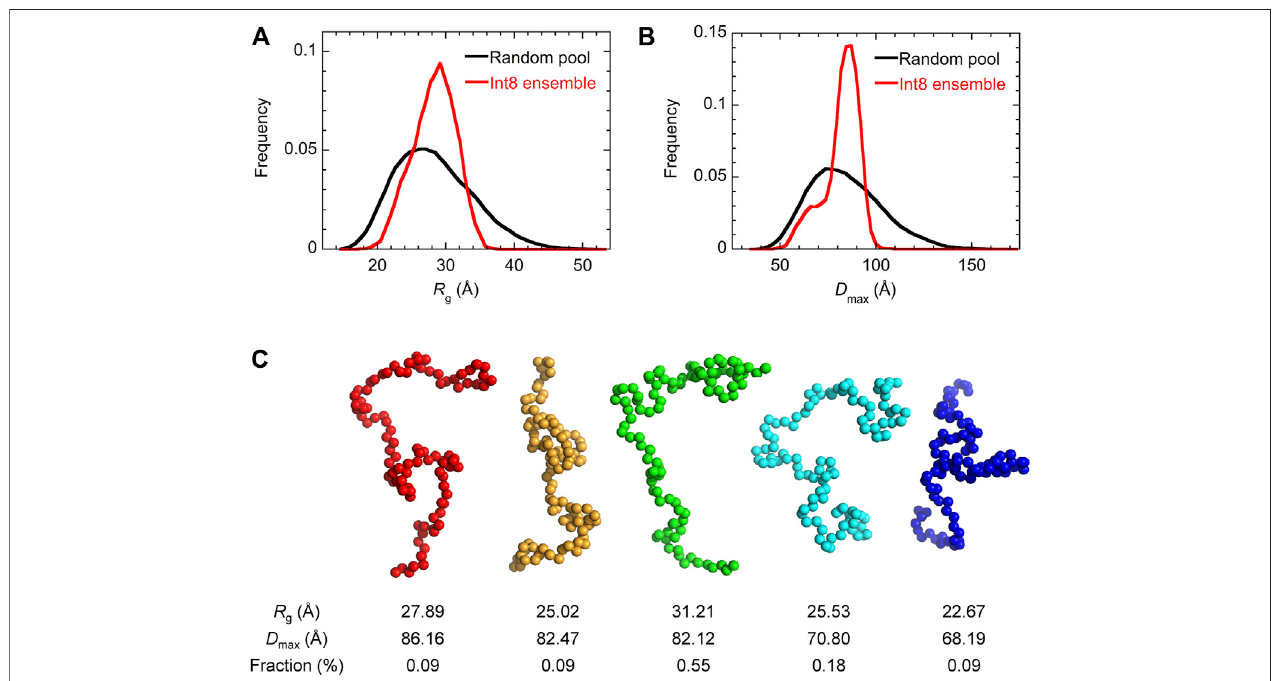
FIGURE 5 | EOM analysis of the SAXS data. (A,B) The distribution of R g (A) and D max (B) for the completely random pool (black) and the ensemble of Int8 conformations (red). (C) Five representative conformations of the wild-type Int8 involved in the ensemble that was best fi tted to the scattering curve of Int8 ( Figure 4A ). The R g , D max , and fraction (%) of the conformations are shown at the